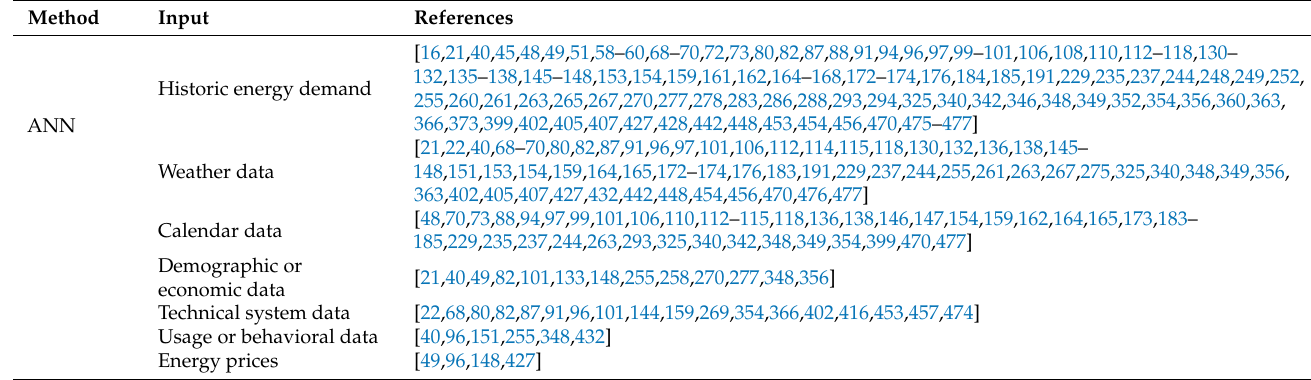
Table A4. Techniques and input data used per article (1/4) (thanks to the reviewers’ advice, Tables 5–9 have been designed in a clear and understandable structure, highlighting techniques and